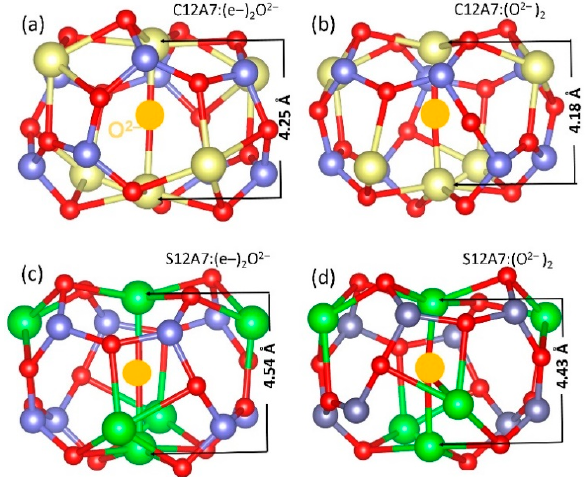
Figure 3. Relaxed cages, containing O 2 − ions in the encapsulated C12A7 and S12A7 electrides. Incorporated O 2 − ions are shown in yellow color. ( a ) C12A7:(e − ) 2 O 2 ‒ , ( b ) C12A7:(O 2 − ) 2 , ( c ) S12A7:(e − ) 2 O 2 ‒ , ( d ) S12A7:(O 2 − ) 2 .